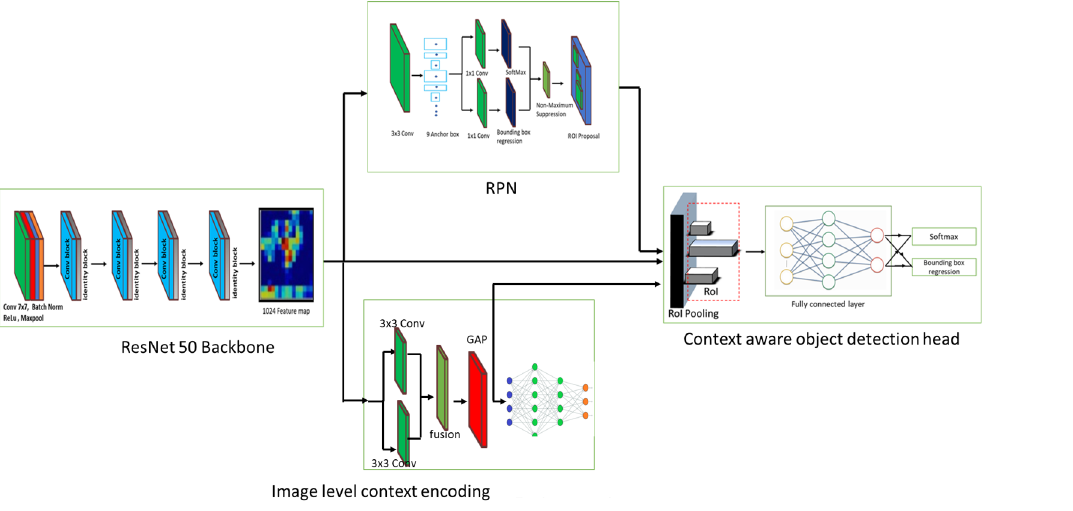
Figure 2. Context aware DCNN-based object detection